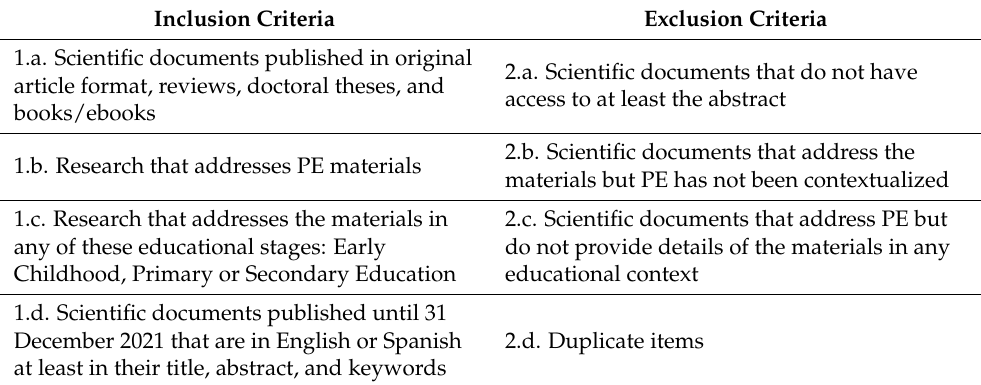
Table 1. Inclusion and exclusion criteria were used in the selection of